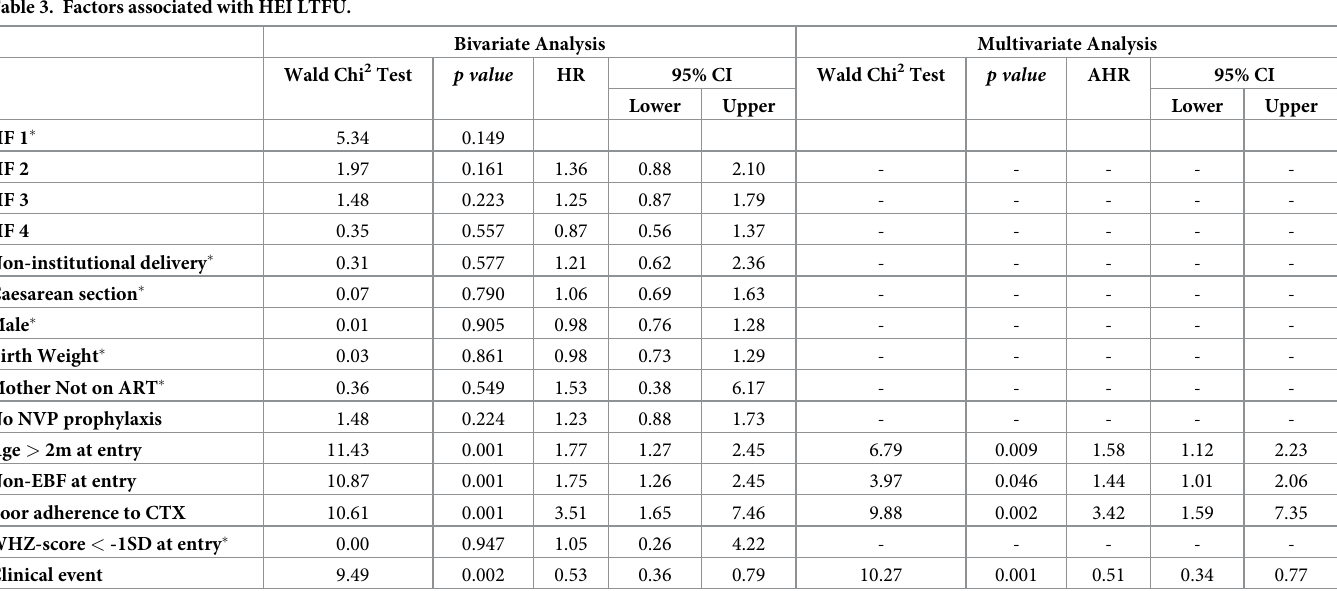
Table 3. Factors associated with HEI LTFU.